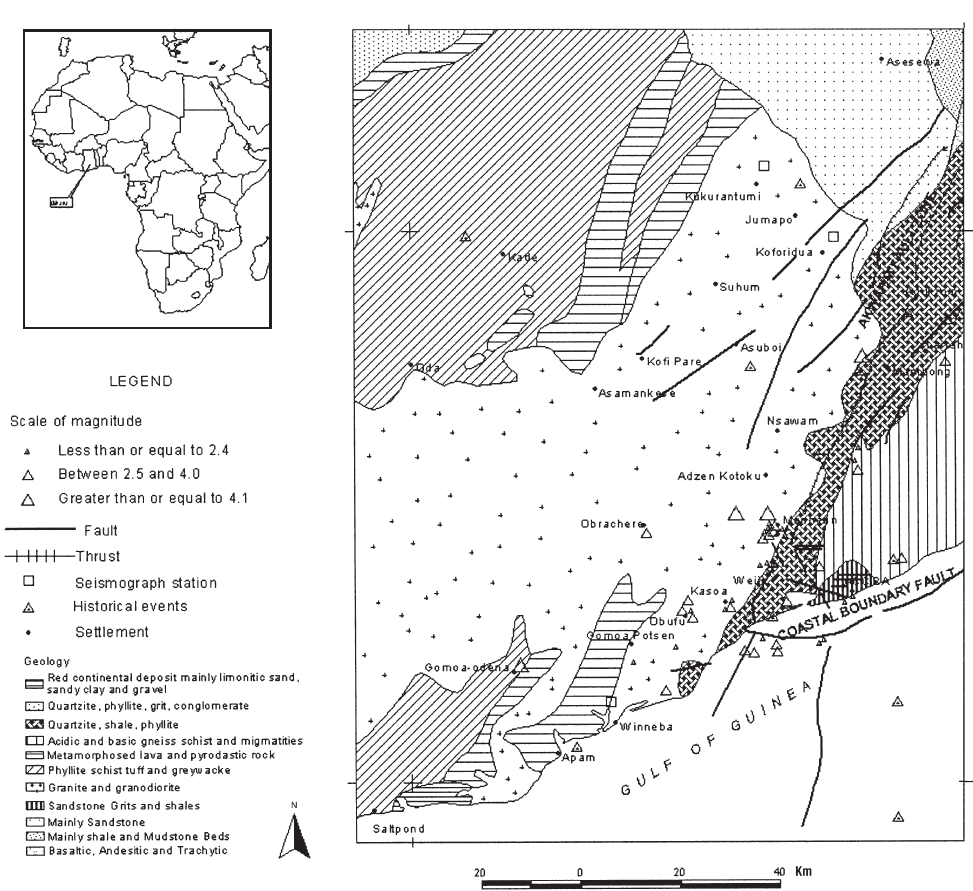
Fig. 1. Seismicity of southeastern